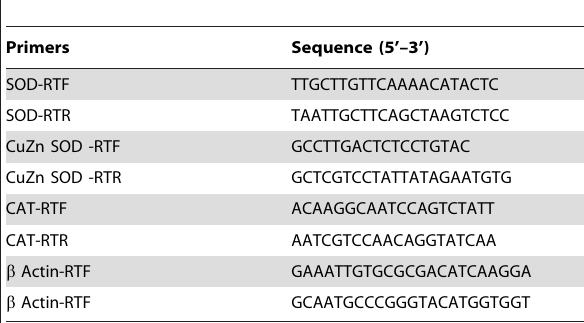
Table 1. Quantitative real-time PCR primers used in the